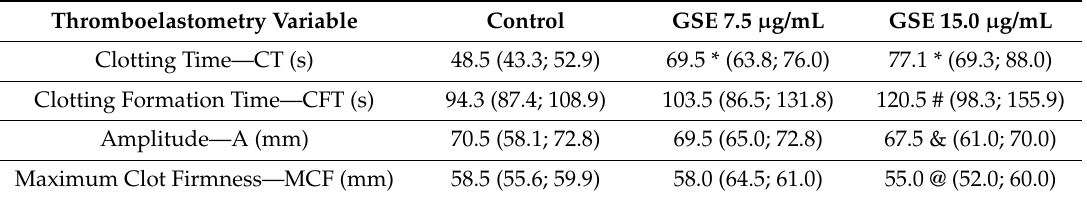
Table 1. The effect of GSE on thromboelastometry variables, as measured by an EXTEM test (ROTEM ® ). Data are presented as a median (interquartile range: LQ-UQ). The significance of the differences was analyzed using a Mann-Whitney U test. * CT control ≠ CT-GSE 7.5 µg/mL and CT-GSE 15 µg/mL -